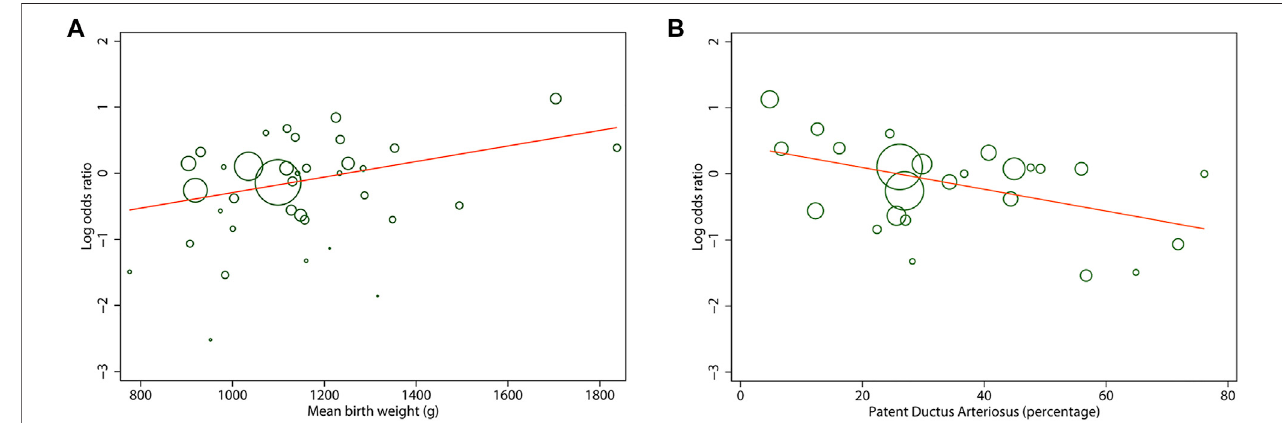
FIGURE 6 | Meta-regression plot of mean birth weight (A) and patent ductus arteriosus rate (B) of the cohort on the log odds ratio in any stage of retinopathy of prematurity between antenatal corticosteroids exposed and non-exposed infants. Each circle size is proportional to the study weight.